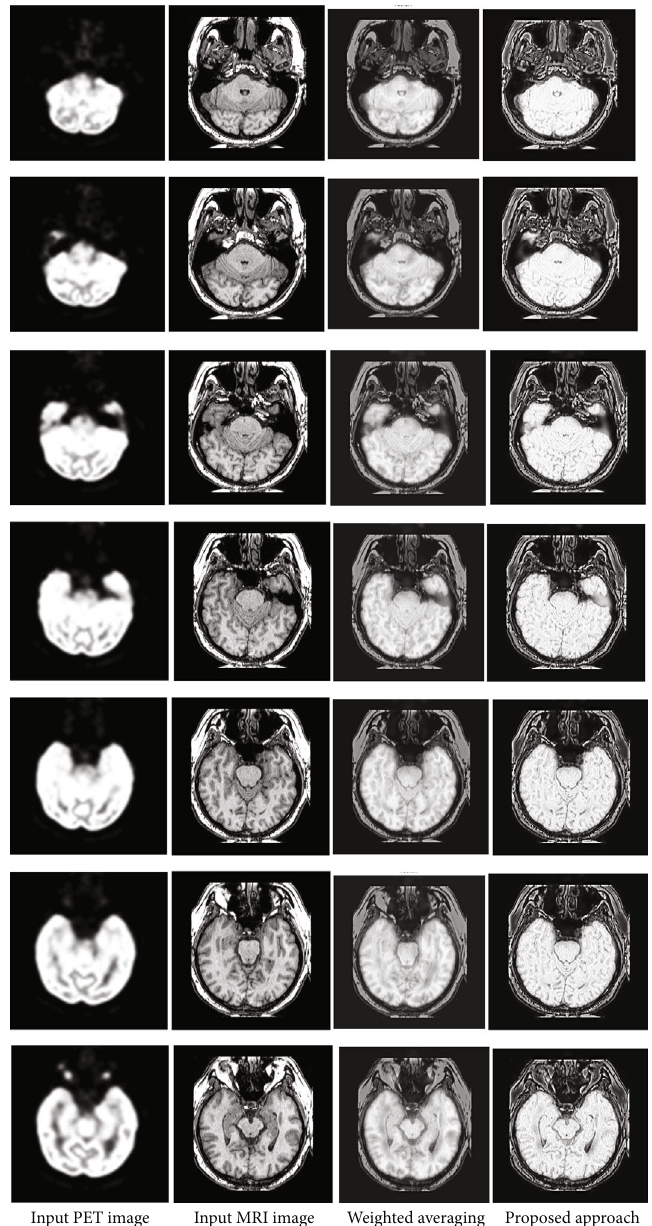
Figure 10: Comparison of obtained fusion results with existing